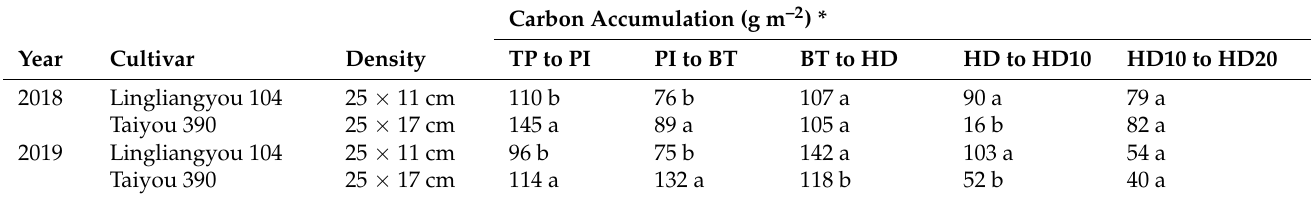
Table 6. Carbon accumulated at different growth stages of two growth-duration rice cultivars under two planting densities in 2018 and 2019.